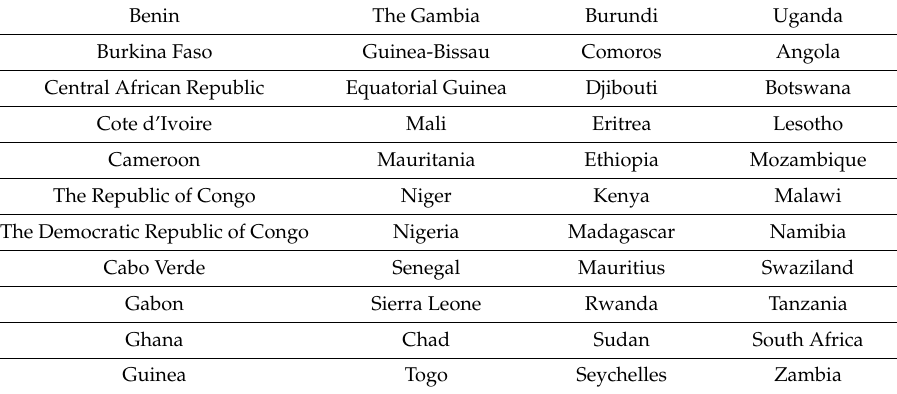
Table A1. List of